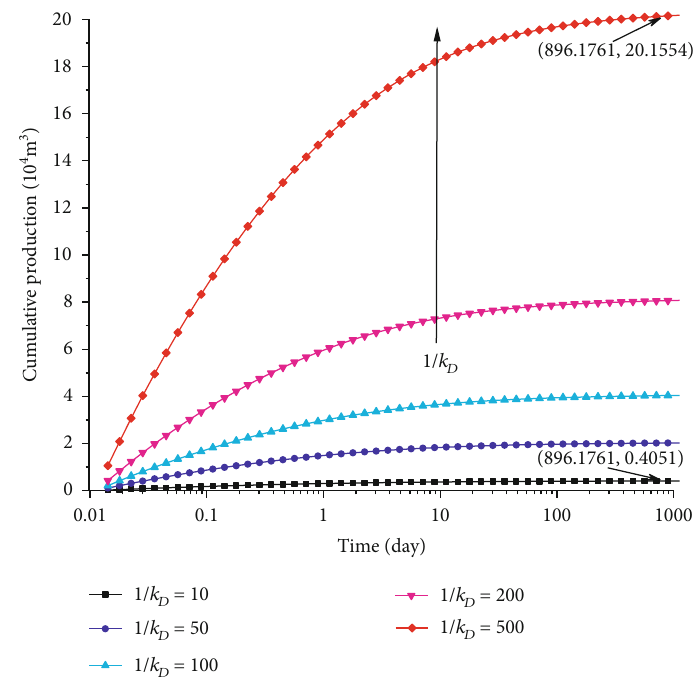
Figure 11: The e ff ect of mobility ratio on cumulative production (constant